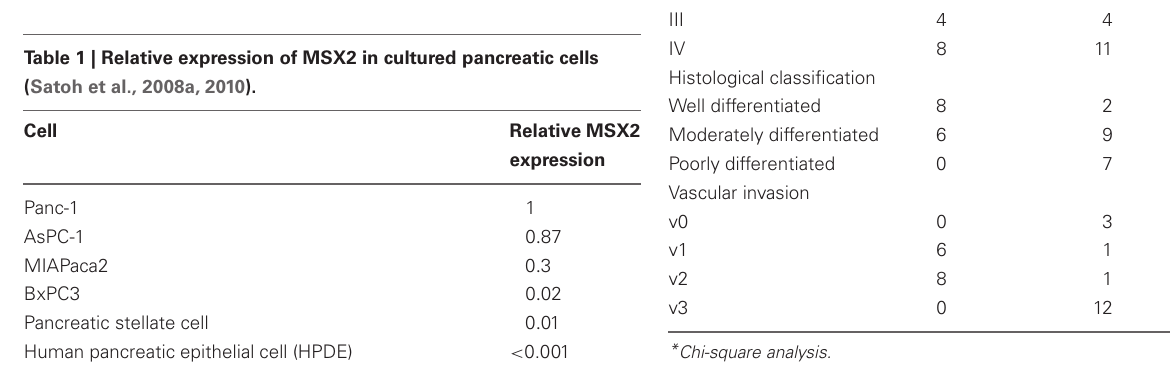
borderline to carcinoma cells in IPMN tissues, while no and